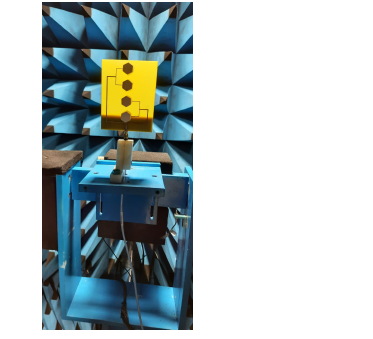
FIGURE 9: Anechoic chamber measurement setup. TE x at 1 . 52 GHz and higher-order mode TE x δ 01 at 3 . 12 GHz and 4 . 25 GHz, shown in Fig. 6(a)-(c).